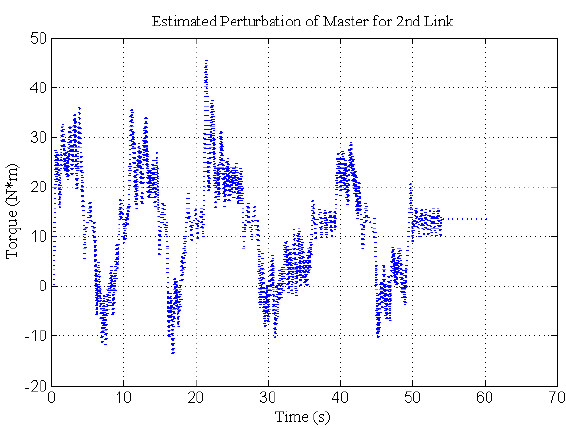
Figure 17. Estimated perturbation of the master’s 2 nd link.